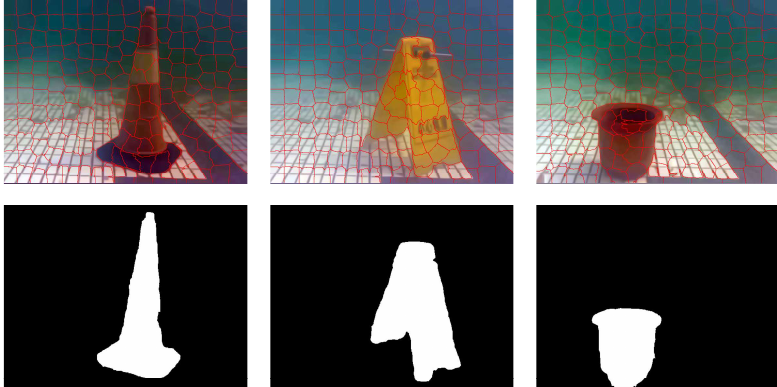
Figure 7. Segmentation results of targets (super-pixels number: 200).